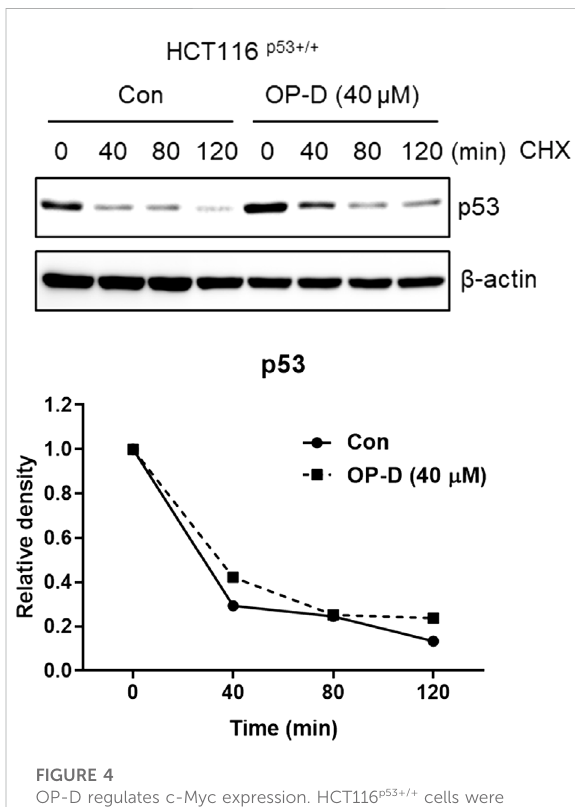
FIGURE 4 OP-D regulates c-Myc expression. HCT116 p53+/+ cells were treated with OP-D (40 μ M) for 24 h. And then, cells were exposed to 50 μ g/mL of CHX at different time points. Cell lysates were performed for c-Myc and and β -actin by Western